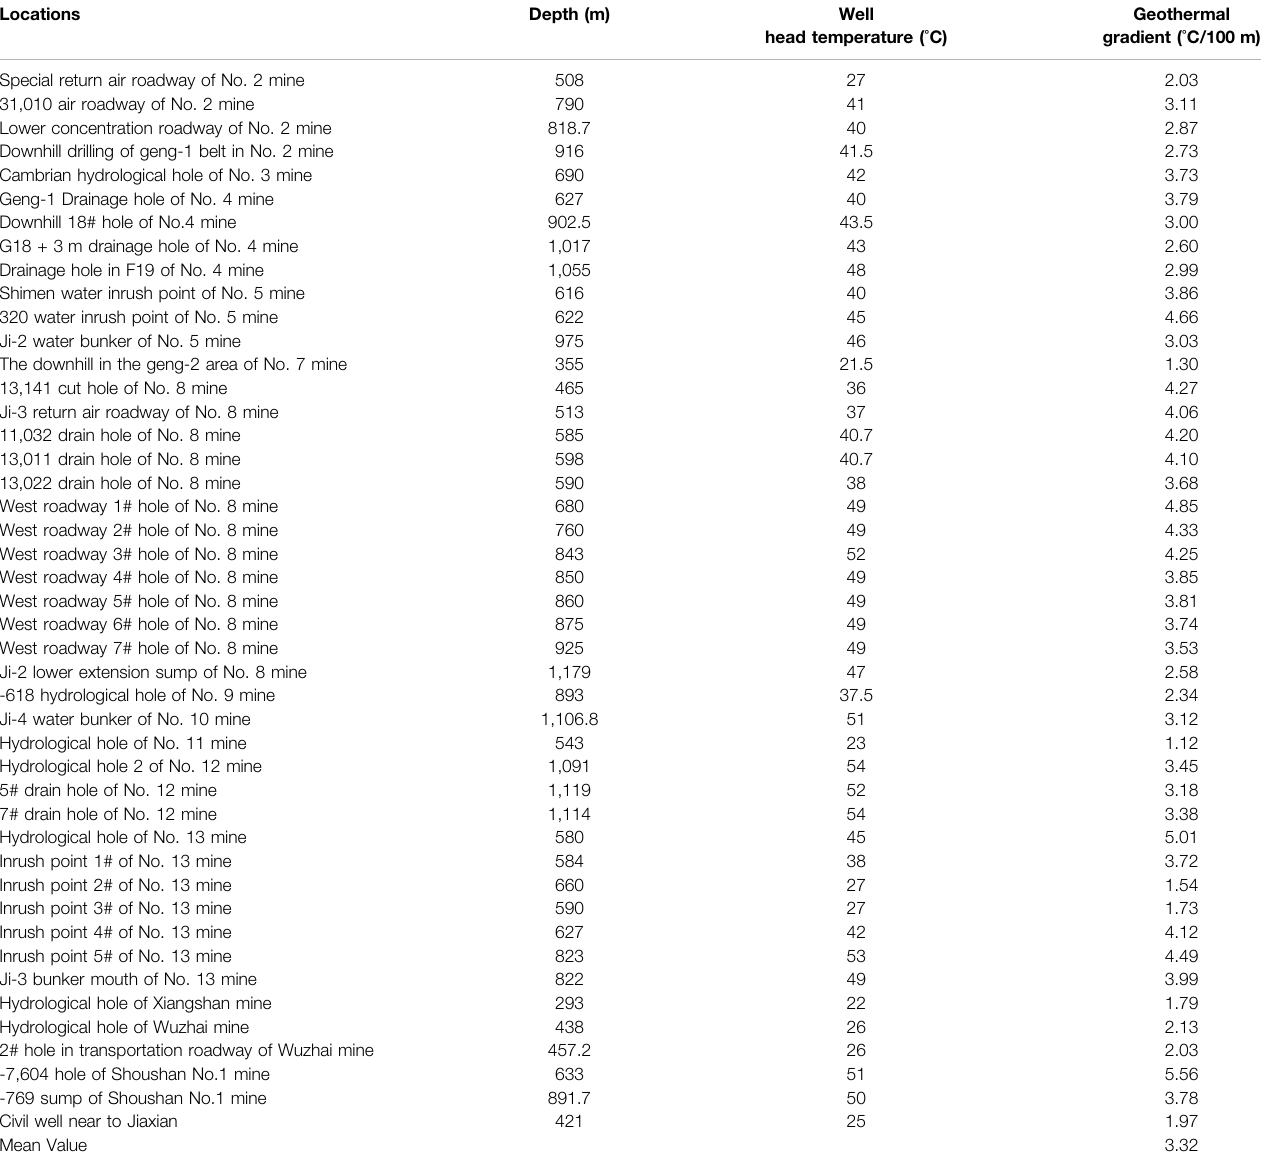
TABLE 1 | Geothermal gradient of cap rock in different mines.